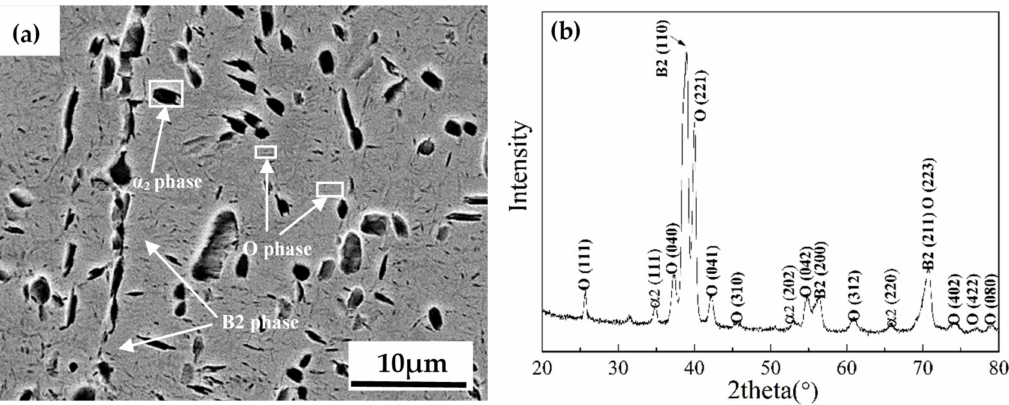
Figure 1. ( a ) Microstructure and ( b ) XRD patterns of Ti-22Al-25Nb